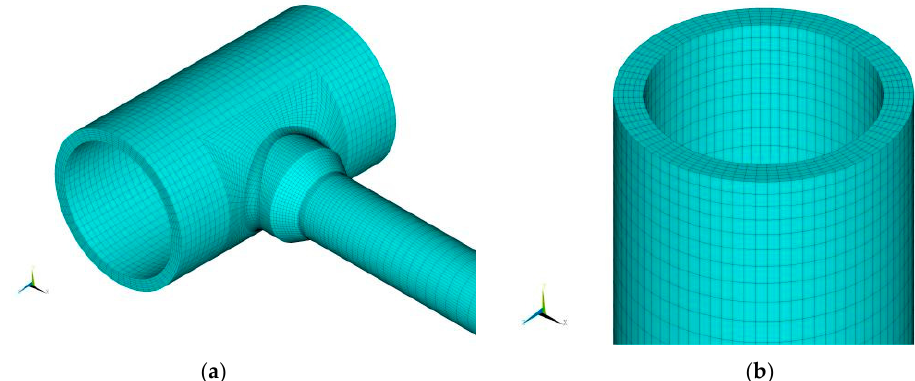
Figure 2. The finite element model of the surge line. ( a ) Ends of the hot leg. ( b ) The pressurizer end. The two ends of the pressurizer surge line were connected to the hot leg and the bottom nozzle of the pressurizer, respectively. So, one end of the hot leg was limited in the axial and circumferential direction, another end was only limited in the circumferen- tial direction. The end-to-connect pressurizer bottom nozzle was limited in both the axial and circumferential direction. The constraints are also illustrated in Figure 3. The estab- lishment of Green’s function is the same as the constraints imposed by finite element ver- ification, and the constraints are applicable to all working conditions.